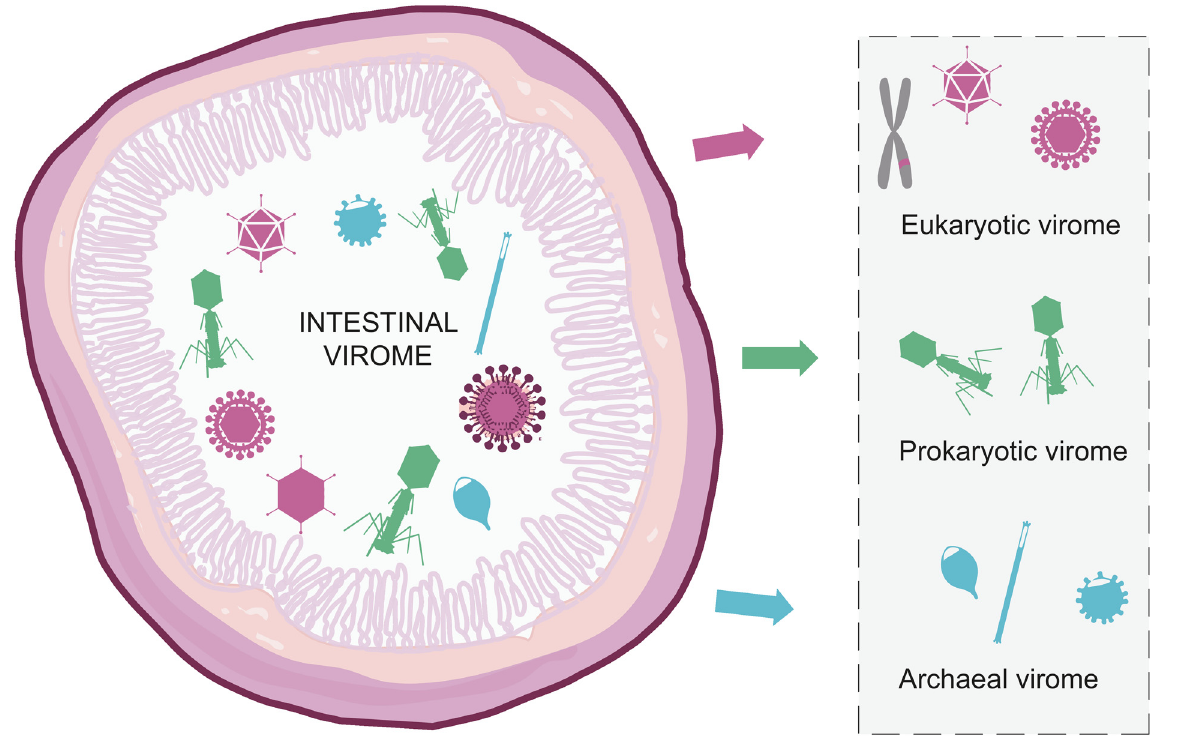
Fig 1. Schematic illustration of the intestinal virome. The mammalian intestinal virome is proposed to have three parts — the eukaryotic, the prokaryotic, and the archaeal. The eukaryotic virome includes host-infecting viruses, viruses infecting other eukaryotes in the intestine, and feed-associated